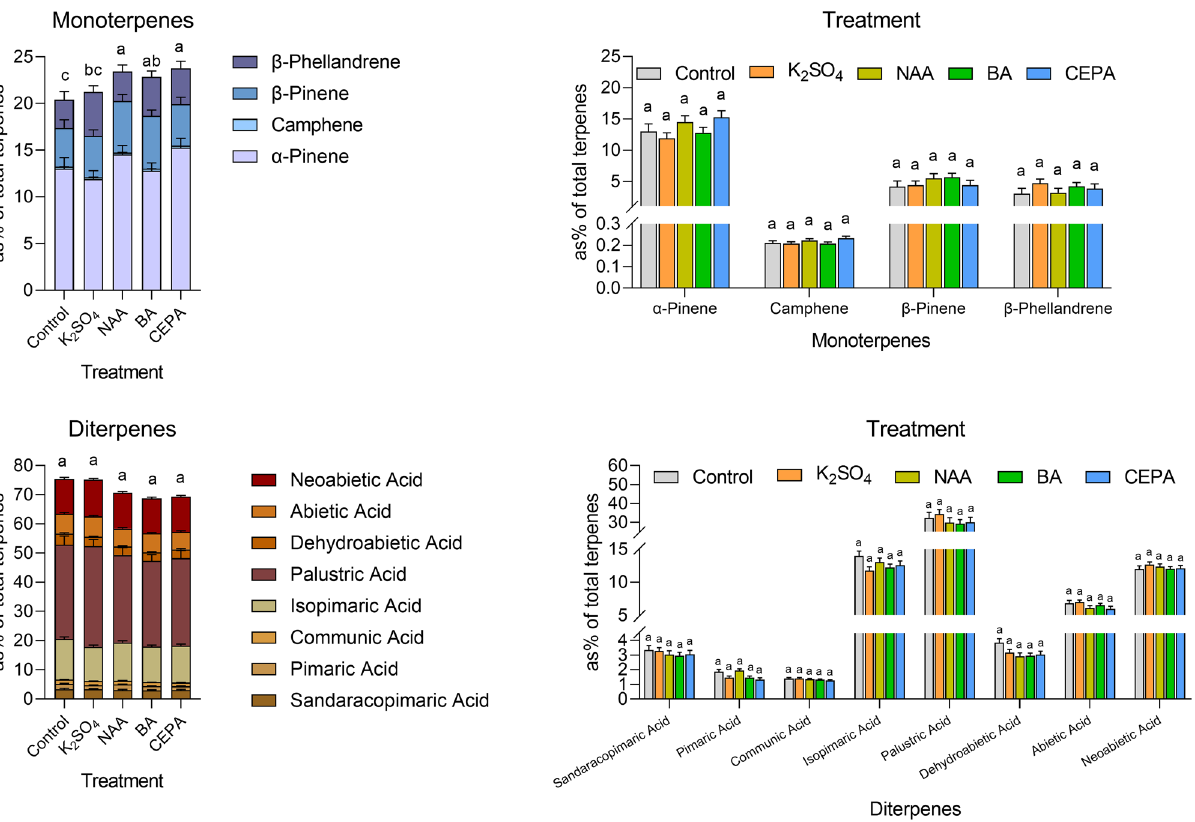
Figure 3. Concentration (as % of total terpenes) of the main resin components from the P. elliottii × P. caribaea trees with or without resin-stimulating paste application. The estimated marginal means of the percentage concentration of each component are shown in the bar plot. Treatment bars not sharing a letter are significantly different (LSD test, P <